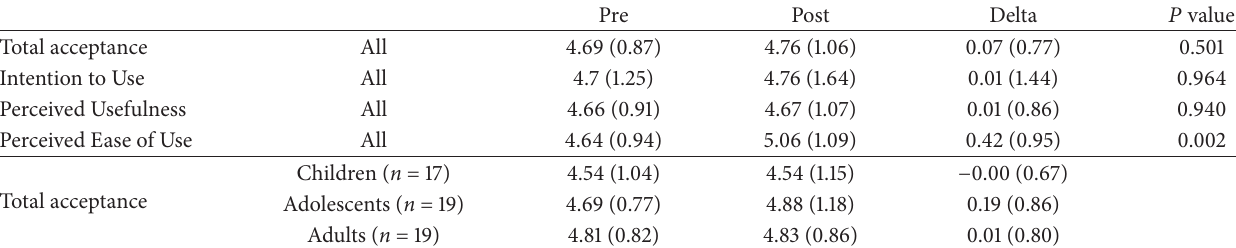
Table 2: Acceptance of an artificial pancreas analysis.